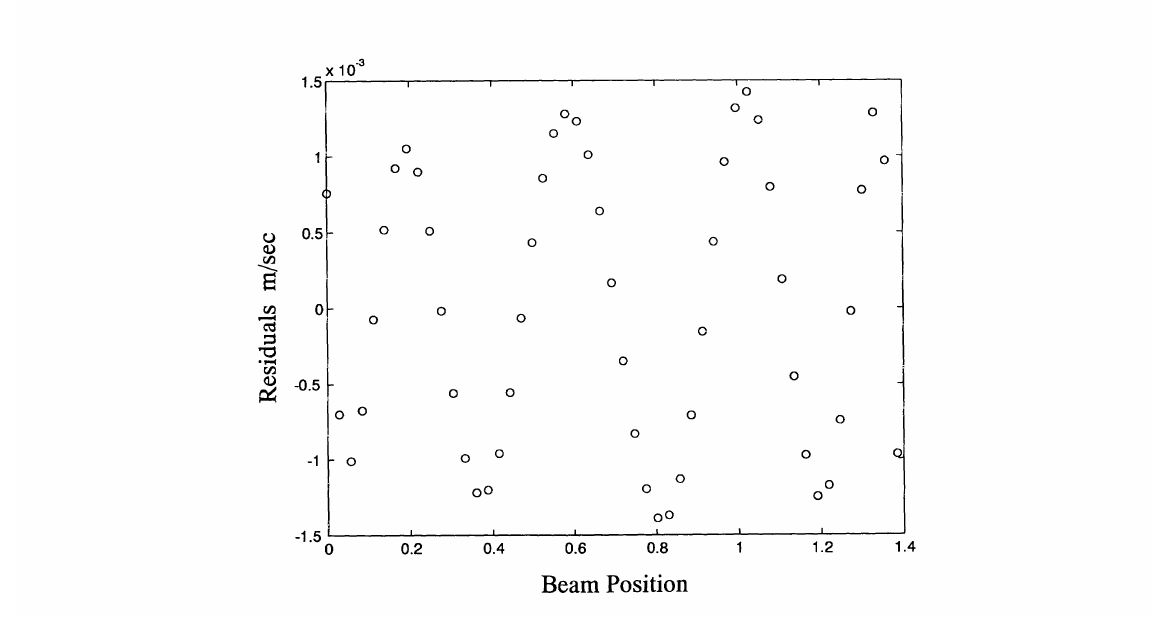
FIGURE 9 Imaginary velocity residuals (experimental vs.